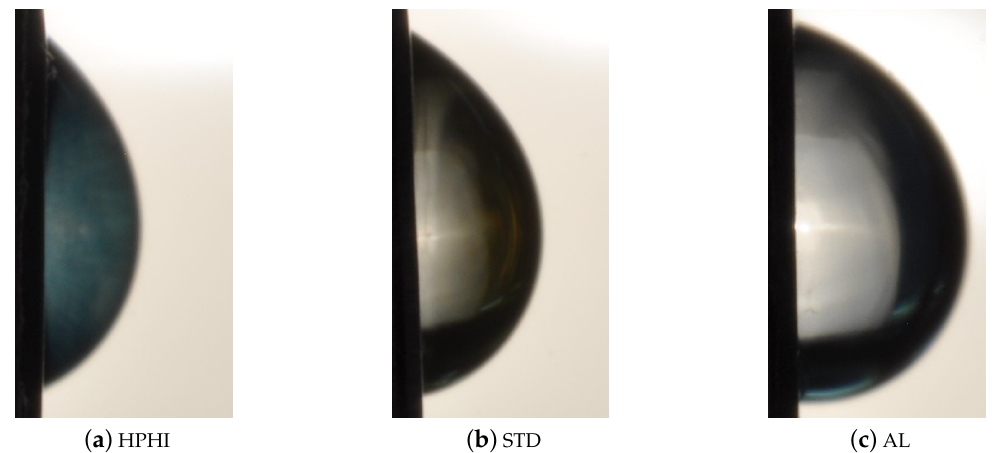
Figure 2. Examples of sessile drops on the three different surfaces investigated in vertical